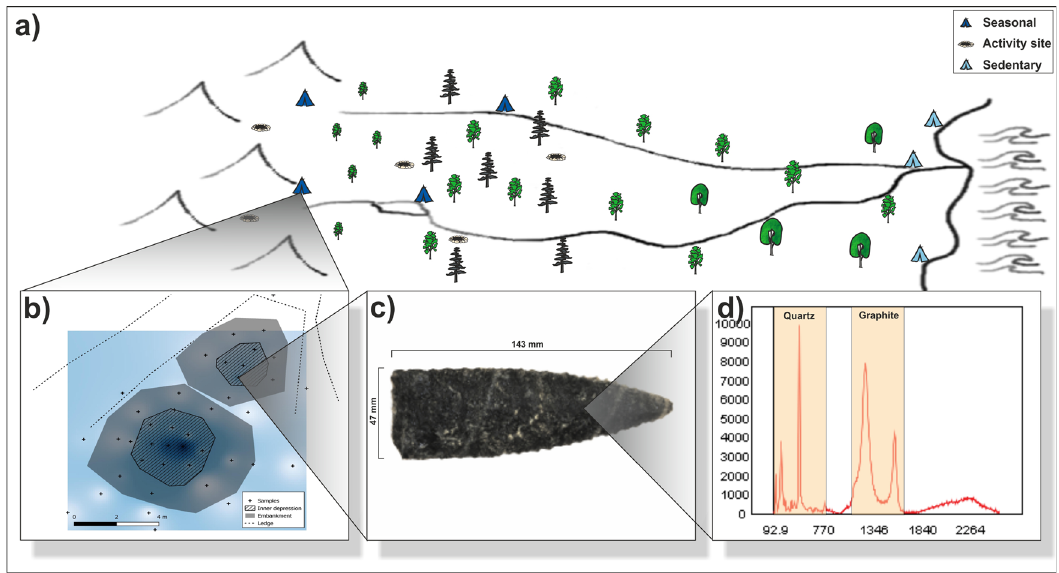
Figure 1: Illustration of the multiscale nature of modelling: ( a ) the hypothetical regional model of settlement patterns among hunter - gatherers is dependent on ( b ) inferences made at a local scale of site function, ( c ) and to assess function it is necessary to perform micro - scale analysis of di ff erent artefacts and data. In some cases, it is also necessary to move further down in scale to the ( d ) molecular level, for instance, to determine the petrographic character of a material. Each level simpli fi es data to some extent, introducing both new uncertainties, as well as information, to the higher - level